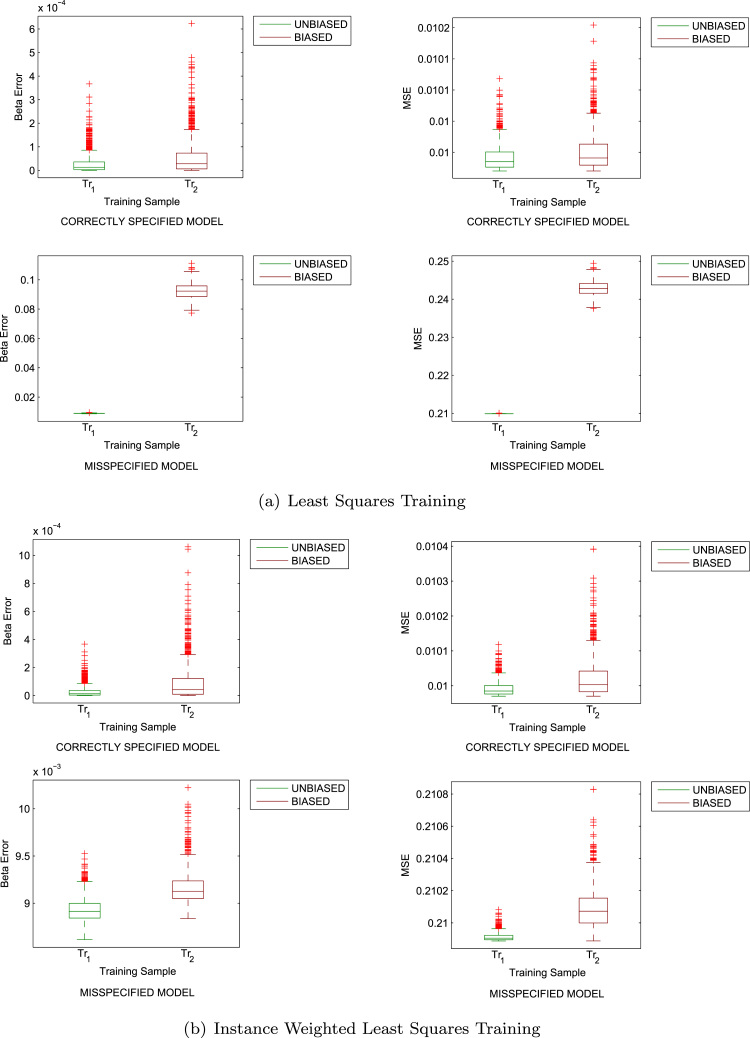
Results using least squares training are shown in (a), while (b) shows results using Instance Weighted least squares. In both figures, the top row shows results when training with a correctly specified model, while the bottom row shows results when training with a misspecified model. The left boxplots in each figure are of ∥β−β^]∥2 while the right boxplots are of the MSE over the test data.